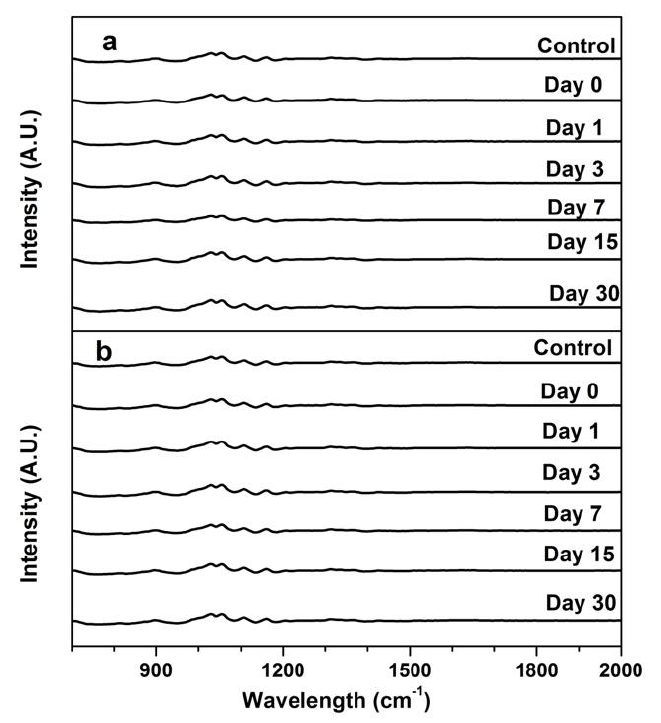
Figure A8. ATR-FTIR spectra of control ( a ) and plasma-treated ( b ) W2 (polyester/cotton) in the range between 700 and 2000 cm − 1 .